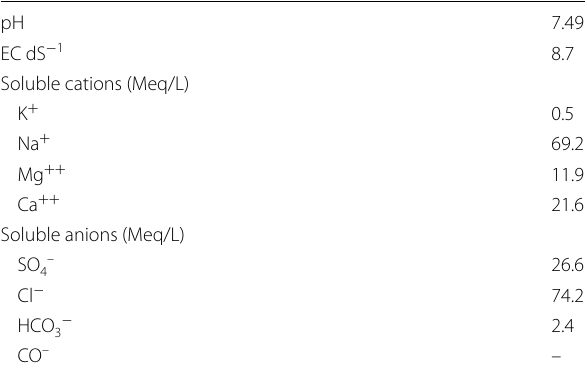
Table 1 Water analysis of Abo Kalam well, El Tour. South Sina